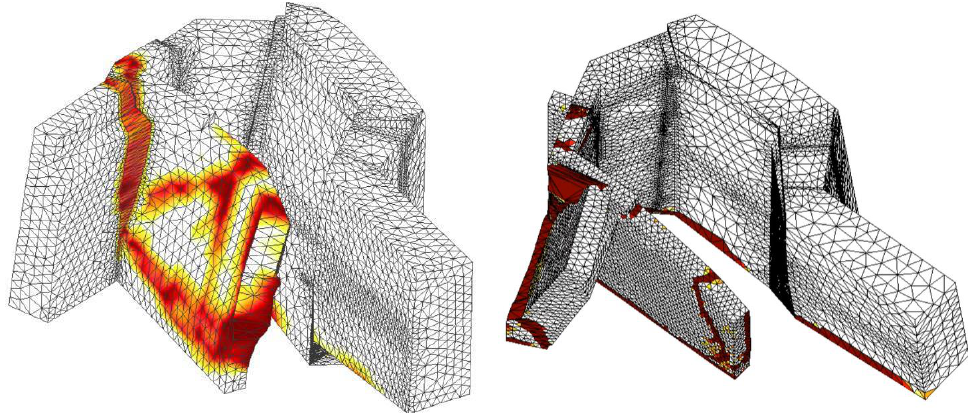
Figure 28. Comparison of tensile damage distribution and deformations for the pushover analyses in EW2 direction considering: ( left ) damaged model with rear wall and ( right ) retrofitted model with lower-bound injections and small buttresses type A. (deformation ×40).